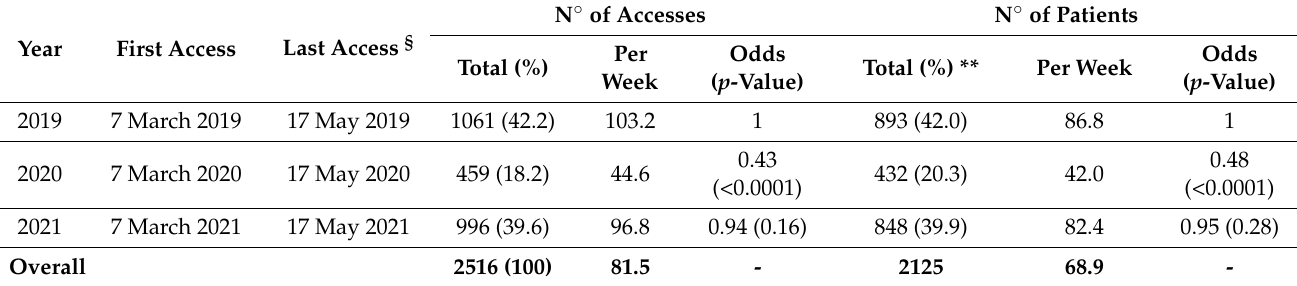
Table 1. ED oncological